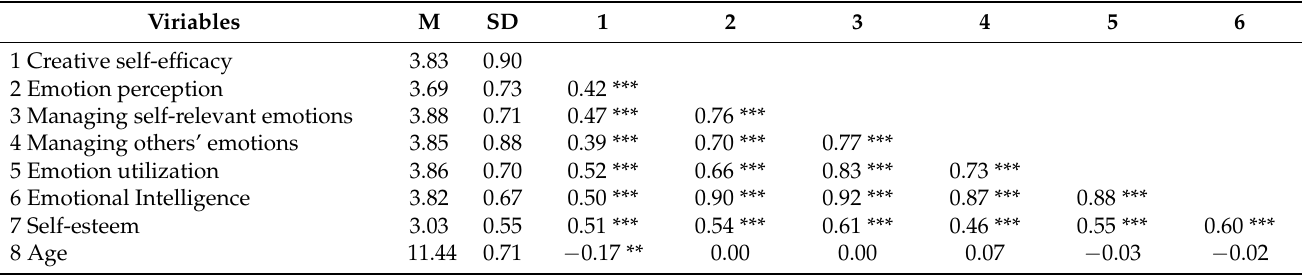
Table 1. Means (M), standard deviations (SD), and correlations among